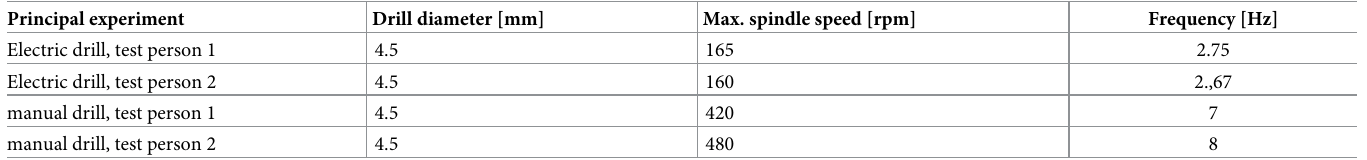
Table 1. Spindle speed of